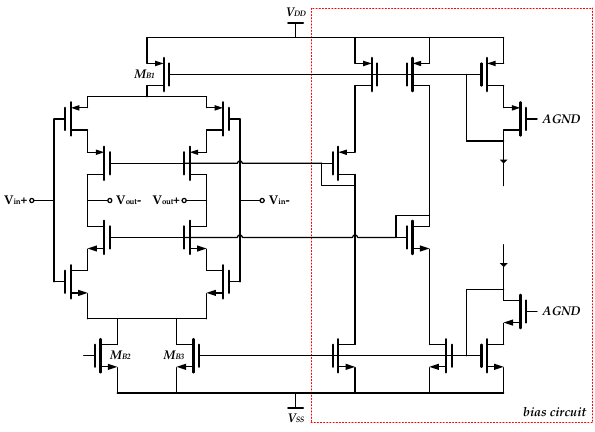
Figure 12. Schematic of inverter-based OTA in analog modulator.